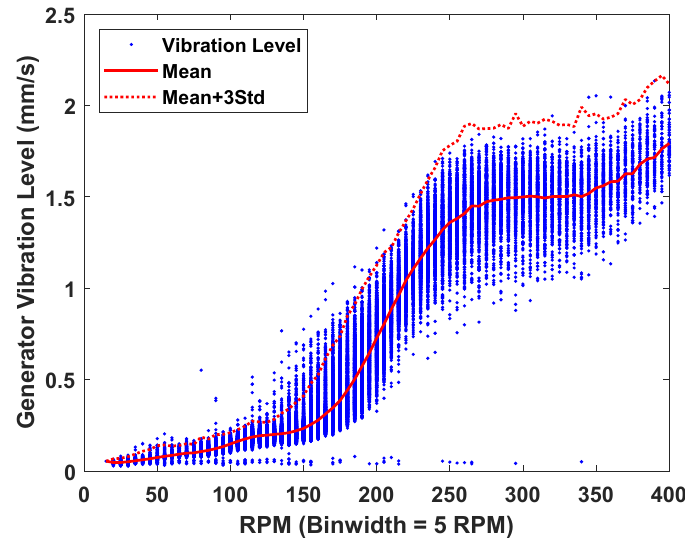
Figure 10. Vibration level of the generator for each 1-minute data set.